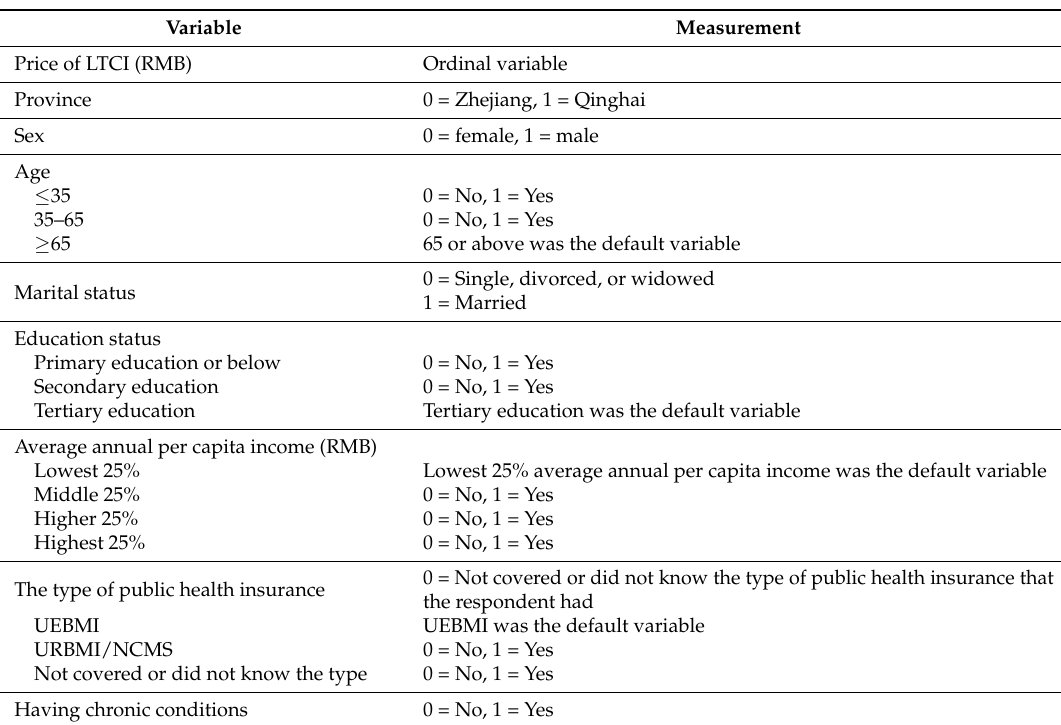
Table 1. Definitions of